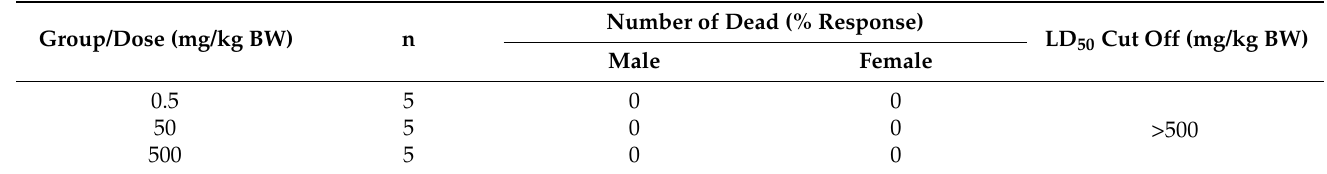
Table 1. Number of dead mice and LD 50 for 14 days of observation in the acute toxicity study of IgY anti-RBD spike SARS-CoV-2.